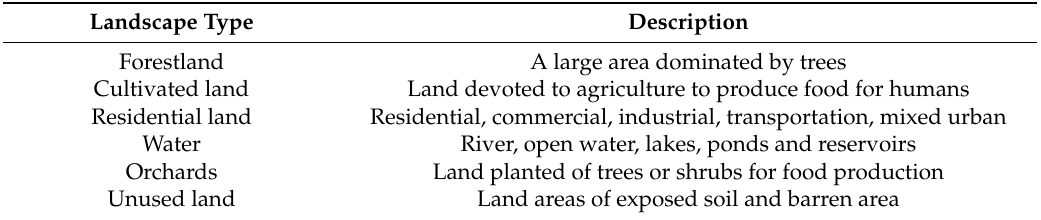
Table 2. Description of each landscape